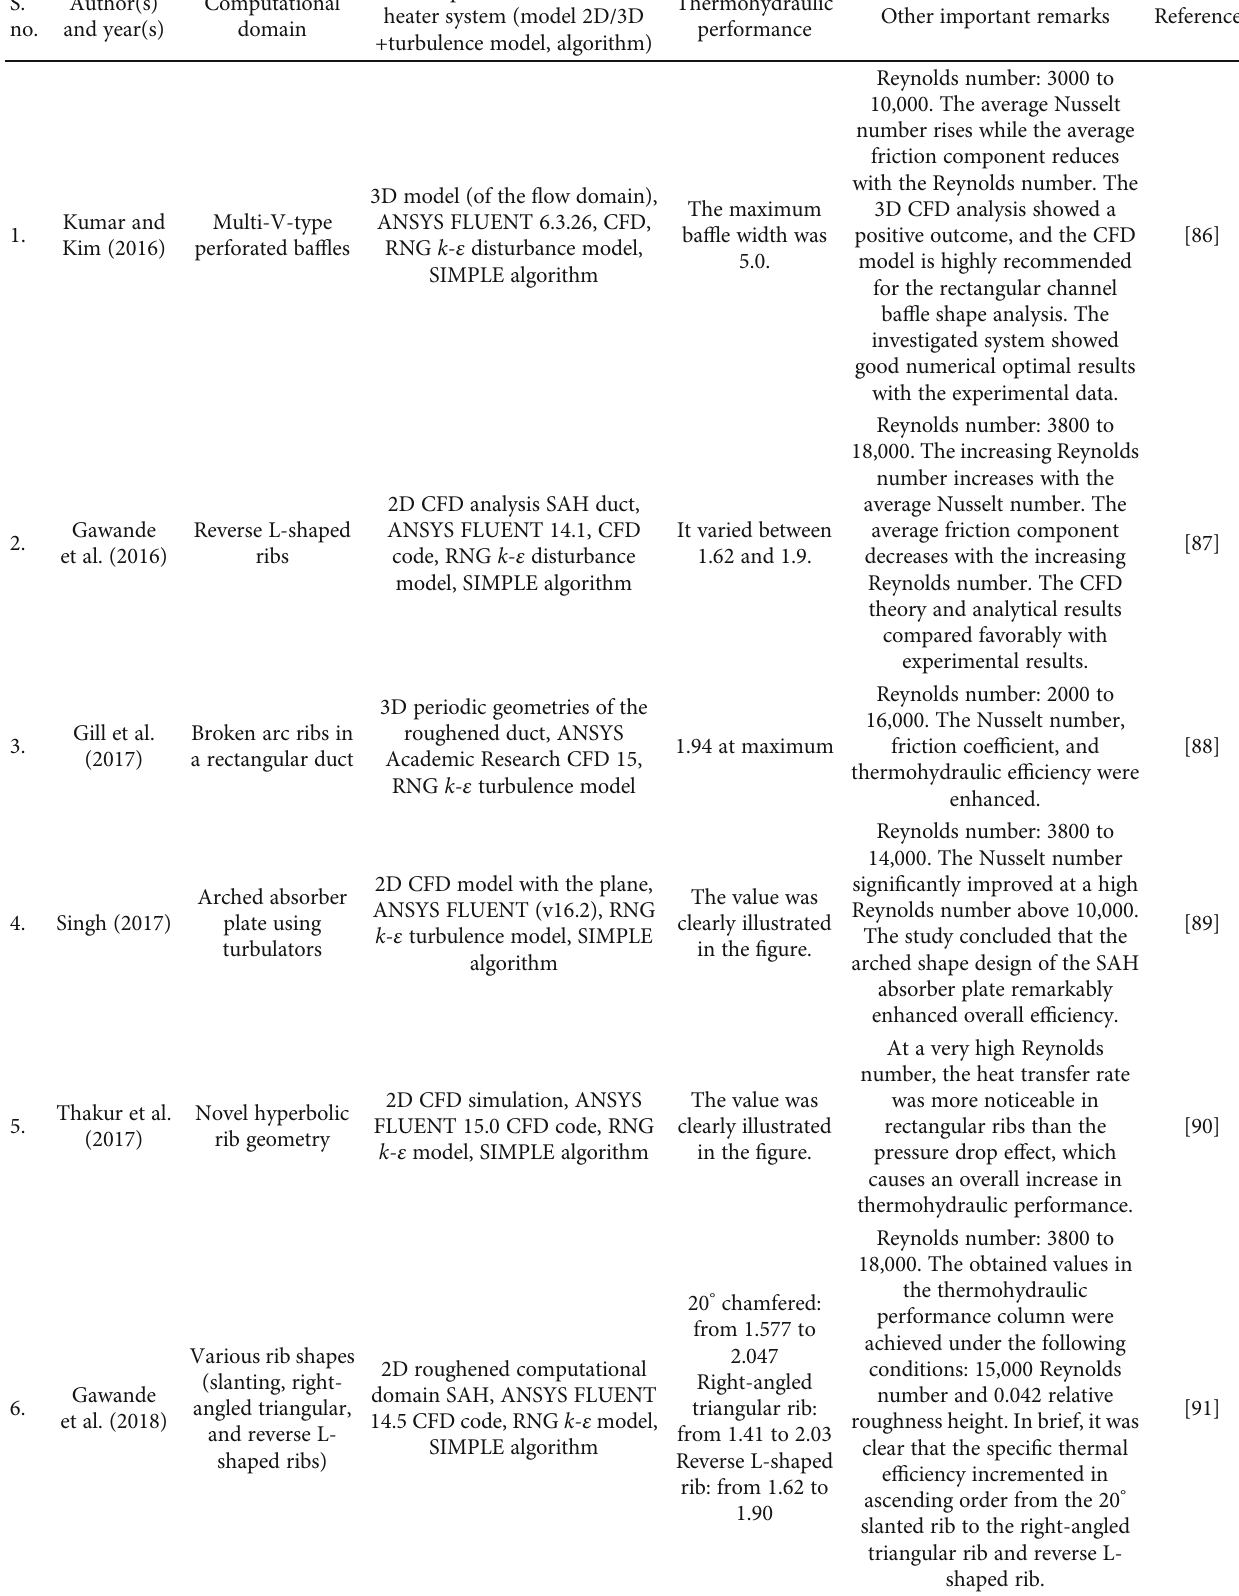
Table 2: Recent important publications on solar air heaters using the thermohydraulic performance principle (2016-2020).